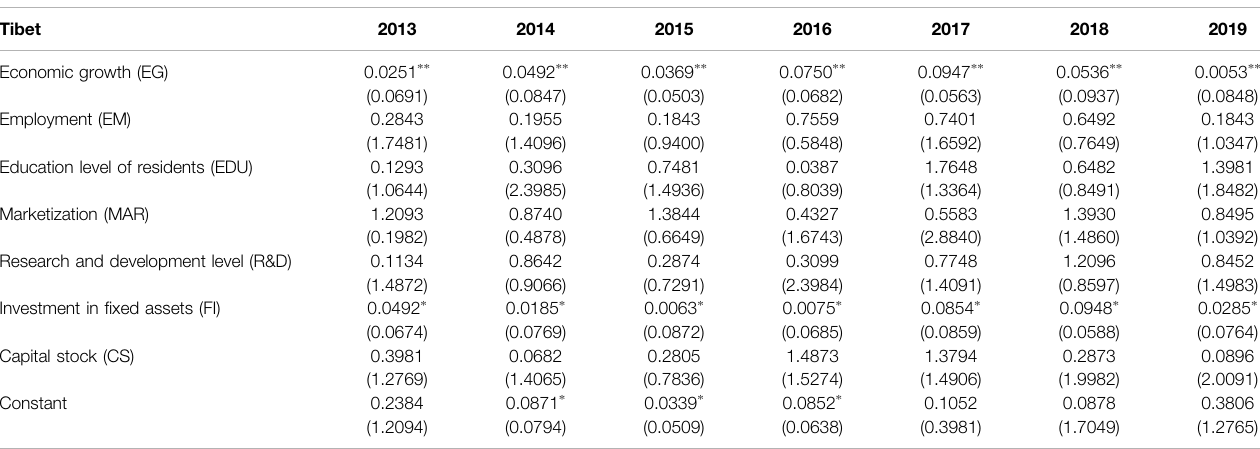
TABLE 18 | Driving force of Tibet health tourism industry convergence.